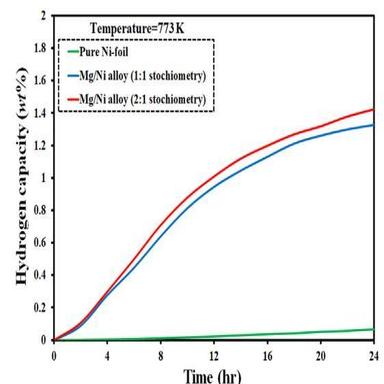
e The kinetics curve (in terms of hydrogen capacity/ storage versus time) for the AFF consolidated Mg/Ni layered composite materials compared to the pure nickel foil alloy under the isothermal dehydrogenation/release testing at a constant temperature of 773 K.